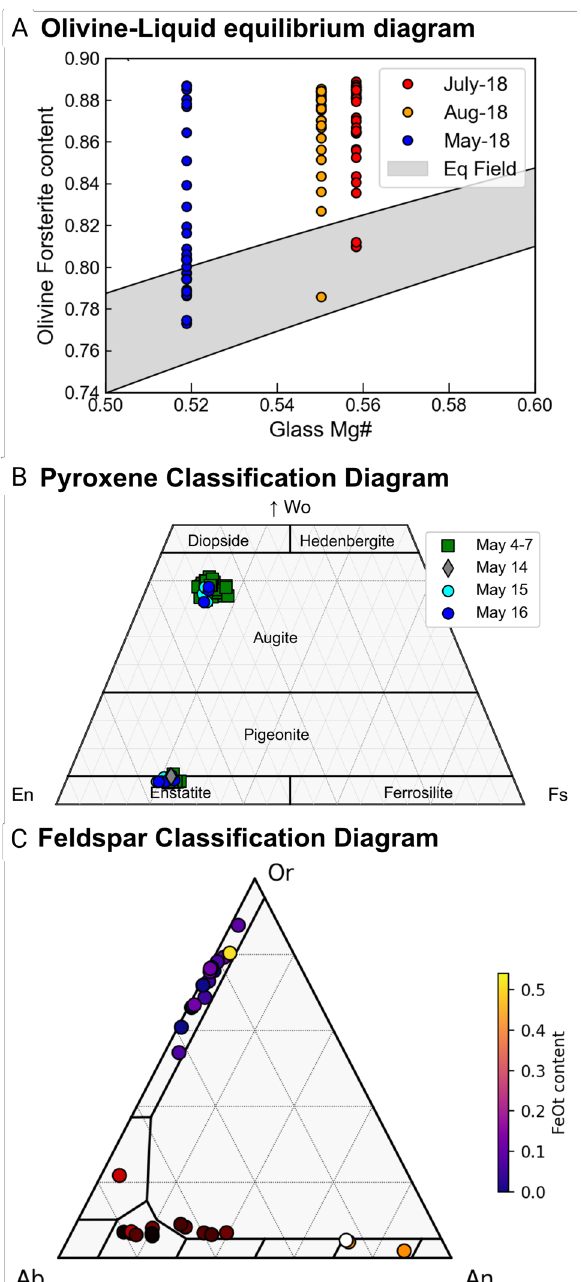
Figure 4: Example plots produced in Thermobar. [A] Olivine- Liquid Equilibrium diagram for samples erupted in May, July and Aug during the 2018 eruption of K¯ılauea Volcano from Wieser et al. [2021]. The equilbrium field spans 𝐾 Ol-Liq of 0.27–0.354 (lower bound from Roeder and Emslie [1970], upper bound from Matzen et al. [2011]. [B] Pyroxene classifi- cation for more evolved samples from the same eruptive event as in [A]. The symbols and colors representing different phases of the eruption defined by their date. [C] Co-existing Plag and Kspar compositions from the experiments of Elkins and Grove [1990]. Symbols are colored based on the FeO